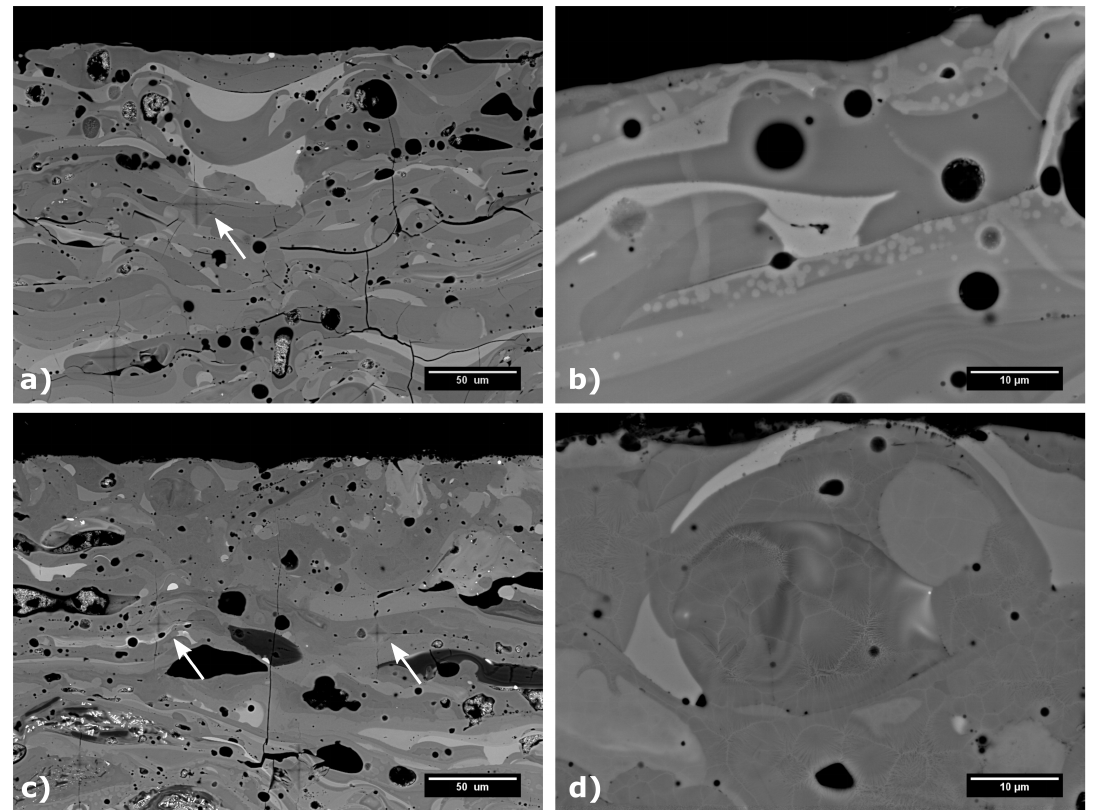
Figure 10. Comparison of the samples heat treated by laser—sample L15 ( a , b ) and plasma—sample P2 ( c , d ). Vickers indents marked by the arrows. Table 2. Crystallinity of the samples. Ratio of t-ZrO 2 and its CDD size. Amorphous Crystalline Amorphous